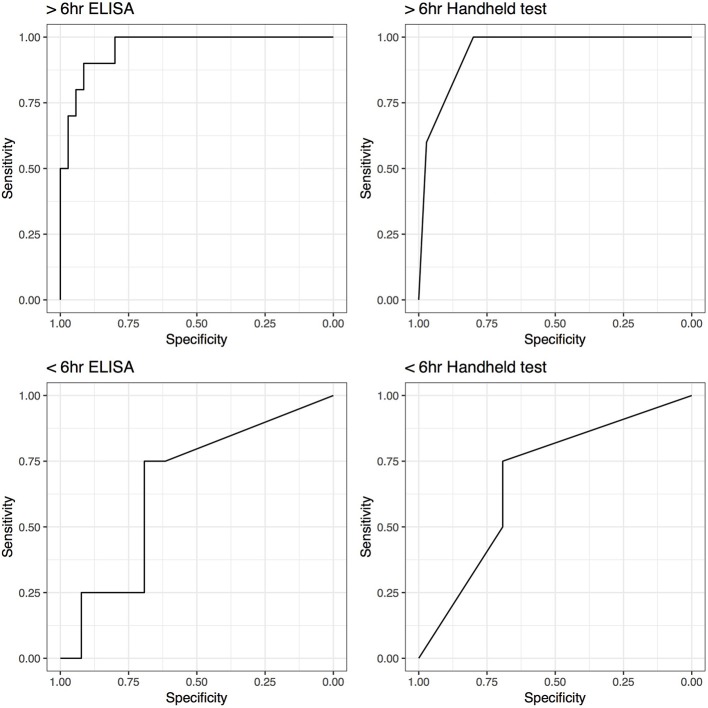
Receiver operating characteristic (ROC) curves for ELISA and handheld SAA tests for horses tested within 6 h (<6 h) and horses tested after 6 h (>6 h) of the onset of the clinical symptoms.